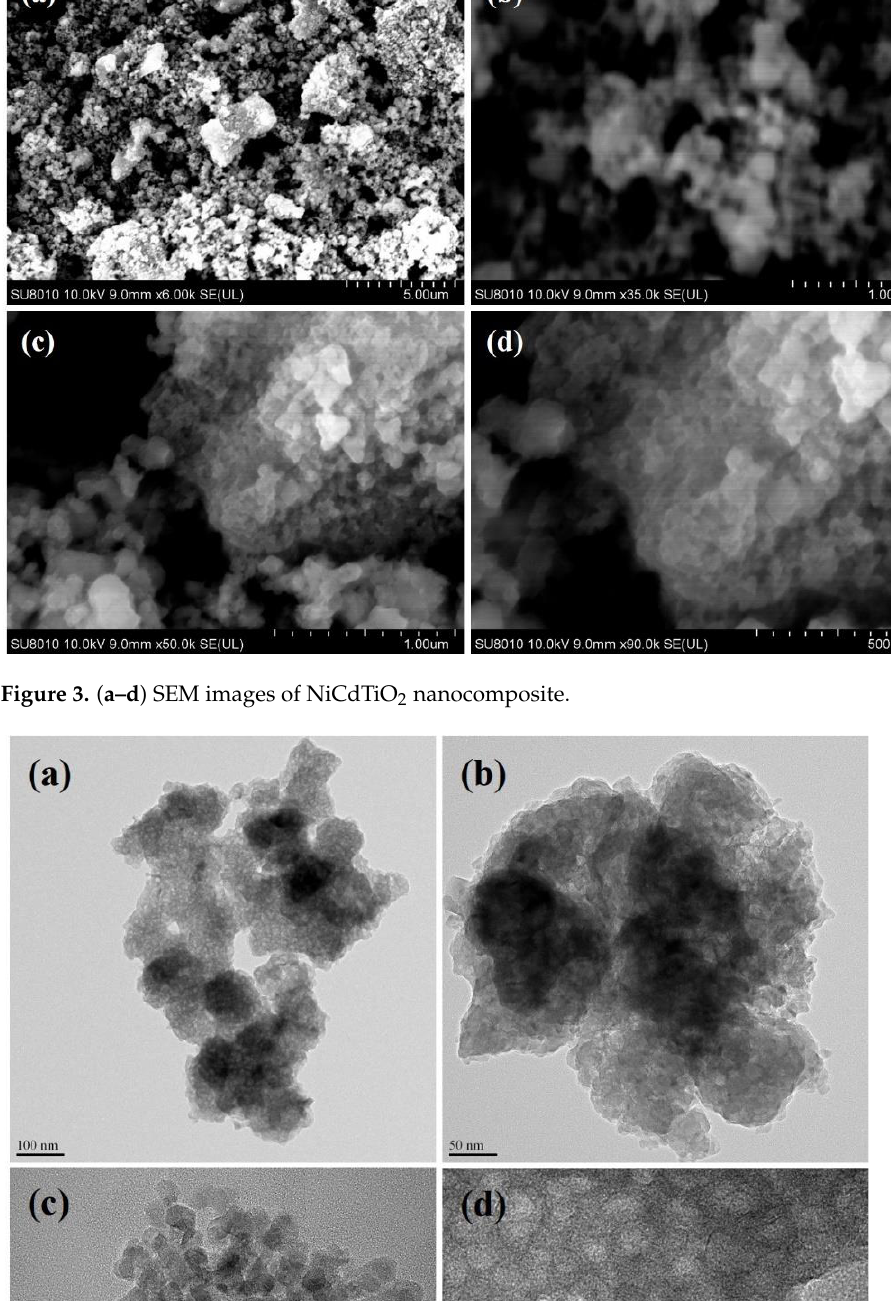
Figure 4. ( a – d ) TEM images of NiCdTiO 2 nanocomposite at different magnifications. Figure 4. ( a–d ) TEM images of NiCdTiO 2 nanocomposite at different